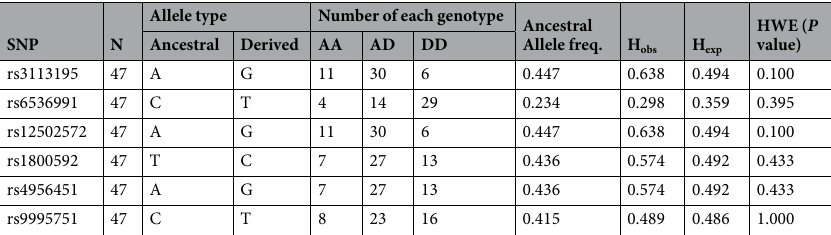
Table 2. Summary statistics of 6 SNPs genotyped in this study. AA, DD, and AD represent a homozygote of an ancestral allele, a homozygote of a derived allele, and a heterozygote of ancestral/derived alleles, respectively. H obs and H exp indicate an observed and expected heterozygosity, respectively. HWE indicates the Hardy- Weinberg equilibrium, and those values are the probabilities that did not deviate from the